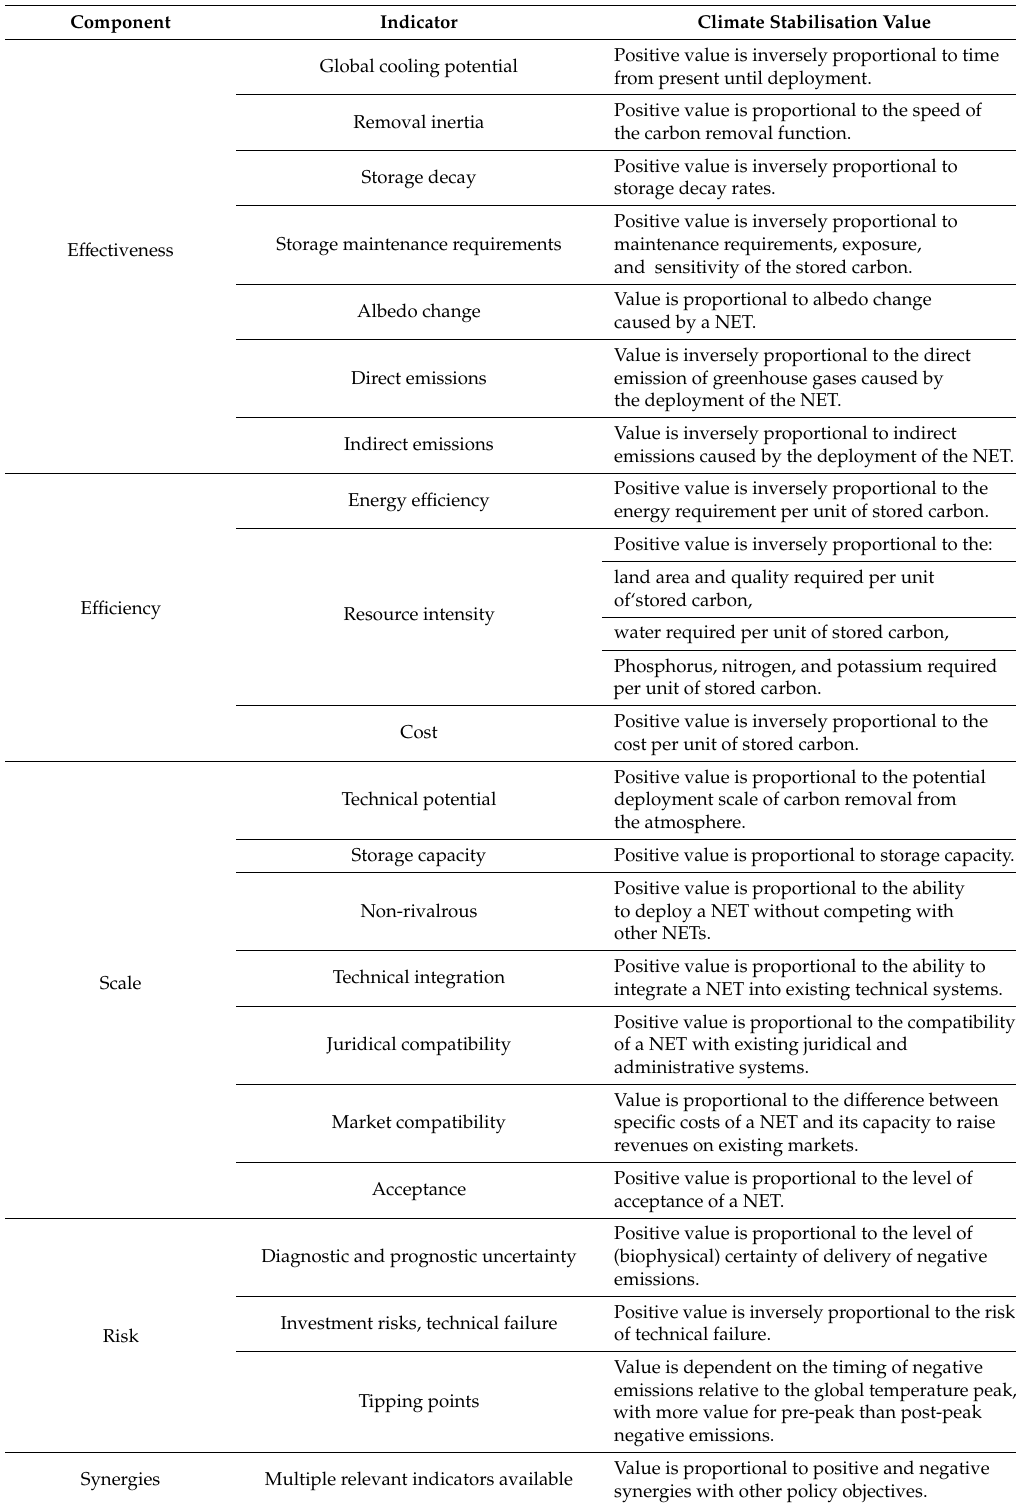
Table 2. Summary of prospective indicators for designing negative emissions climate stabilisation value